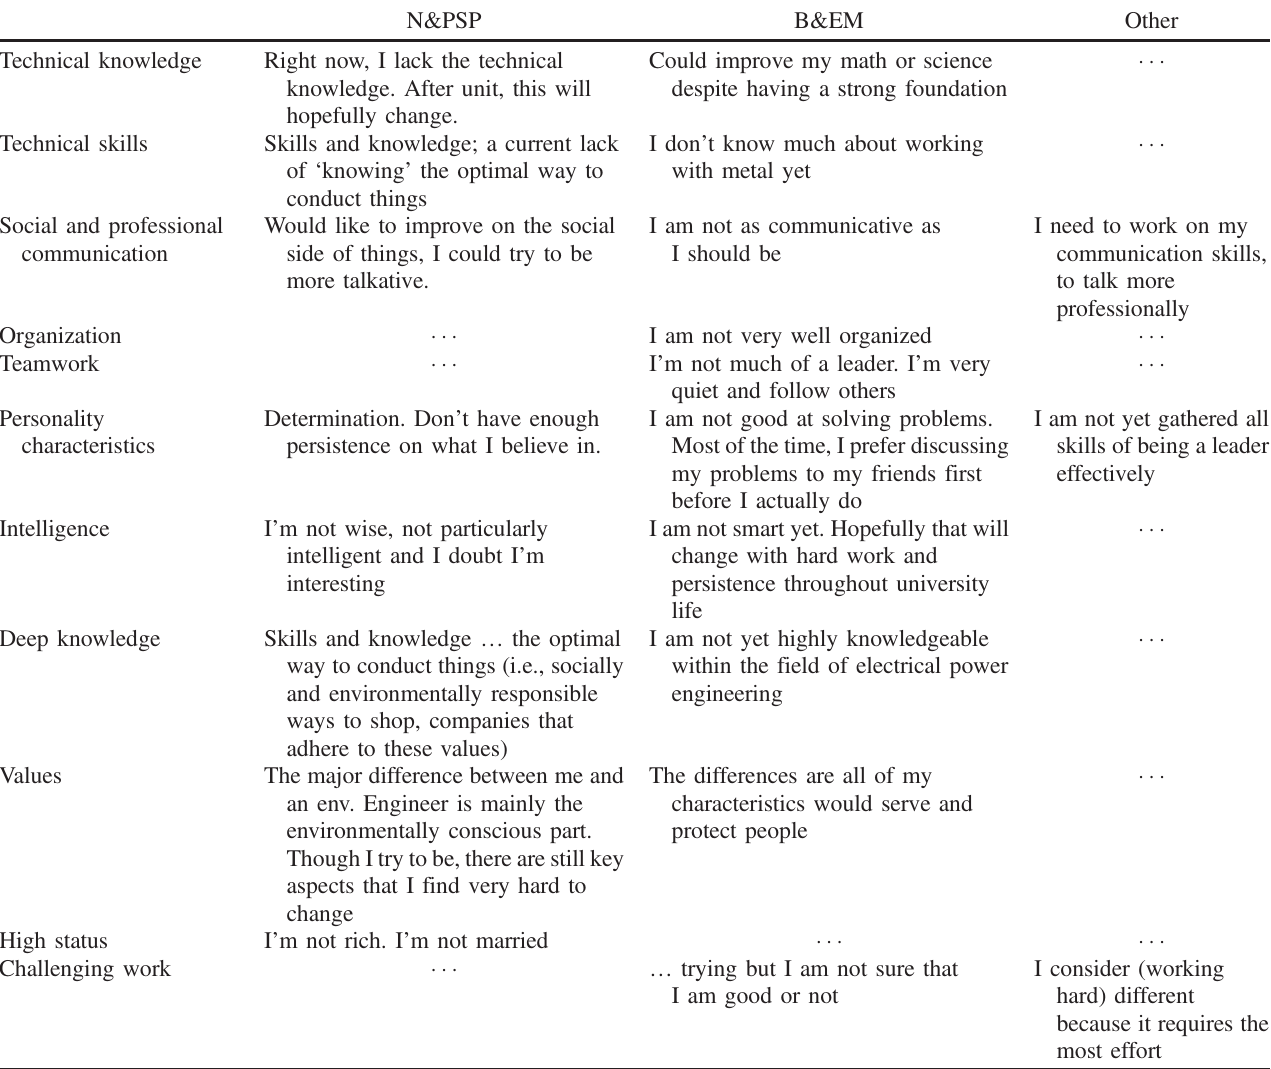
TABLE IV. Example responses for how the self differs from the perceived characteristics of professional by occupational grouping N&PSP Technical knowledge Technical skills